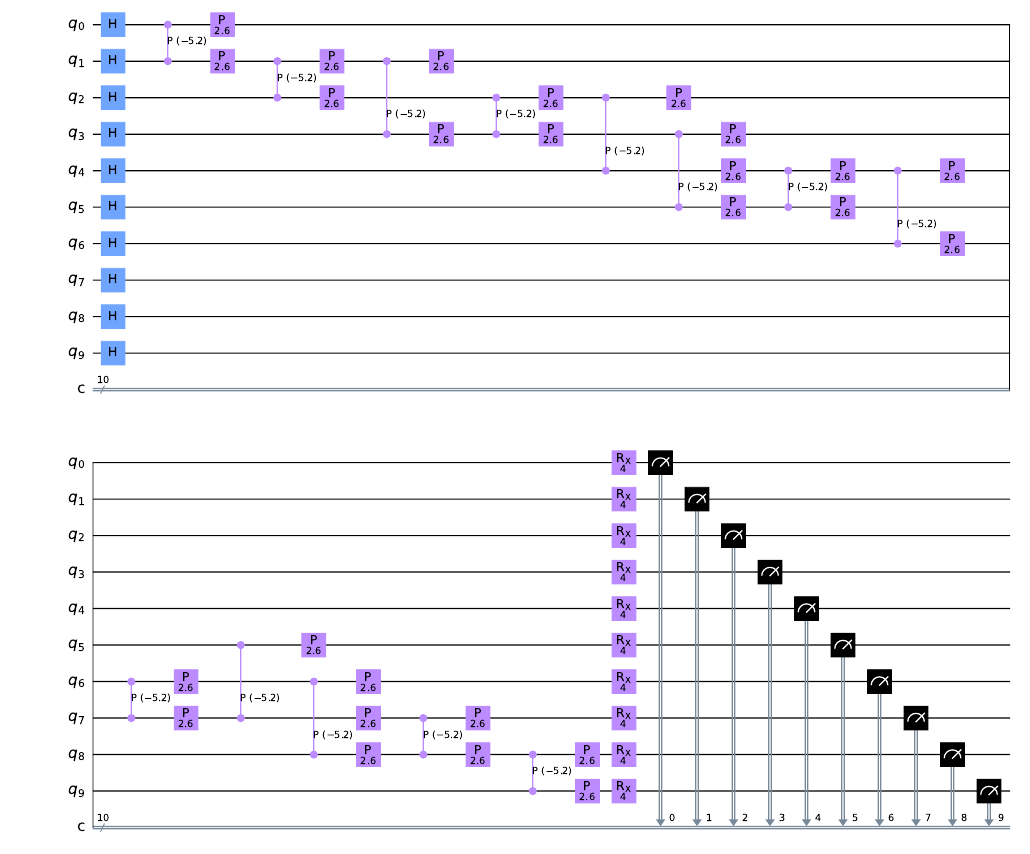
Figure 4. QAOA—Farhi et al.